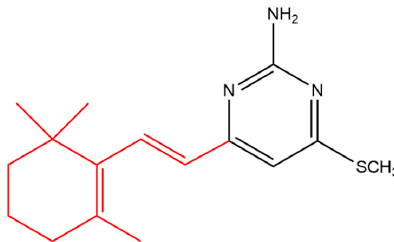
Figure 14. ( E )-4-(methylthio)-6-(2-(2,6,6-trimethylcyclohex-1-en-1-yl)vinyl)pyrimidin-2-amine. The β - ionone moiety is shown in red .